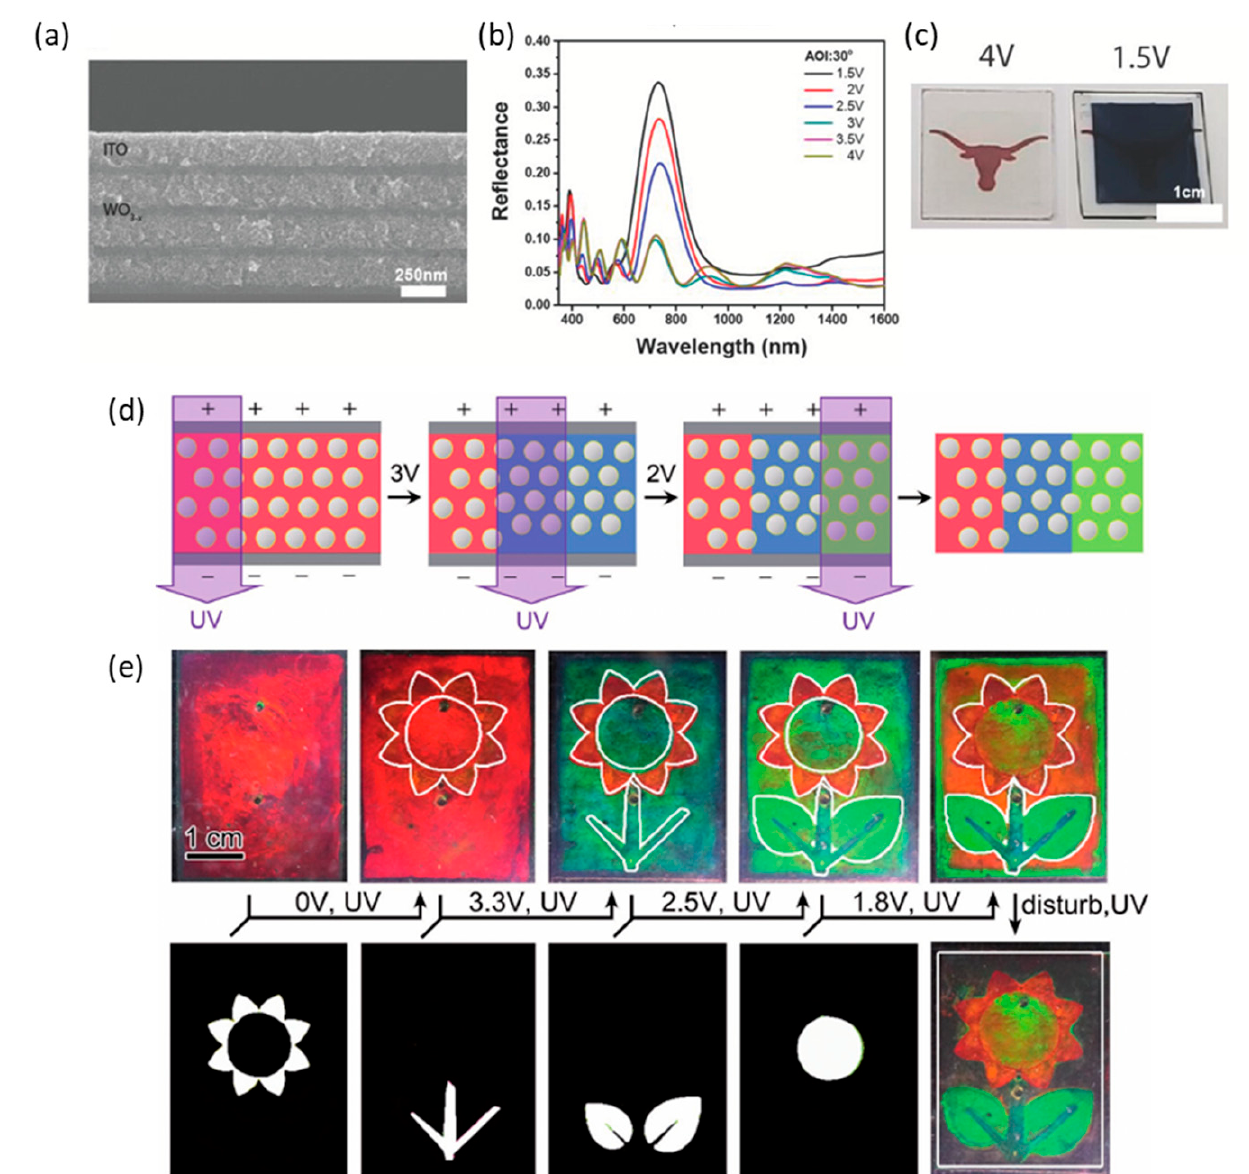
Figure 4. ( a–c ) Cross-sectional SEM image, reflectance spectra and optical image of 1D photonic crystals constituted of indium tin oxide (ITO) NCs and WO 3-x NC layers (BS1). Adapted from reference [90] under permission from John Wiley & Sons. Effect of an electric tuning and UV curing combination on E-ink. ( d ) Schematic mechanism and ( e ) optical example of lithographical printing by photomask covering. Adapted from reference [91] under permission from John Wiley & Sons.